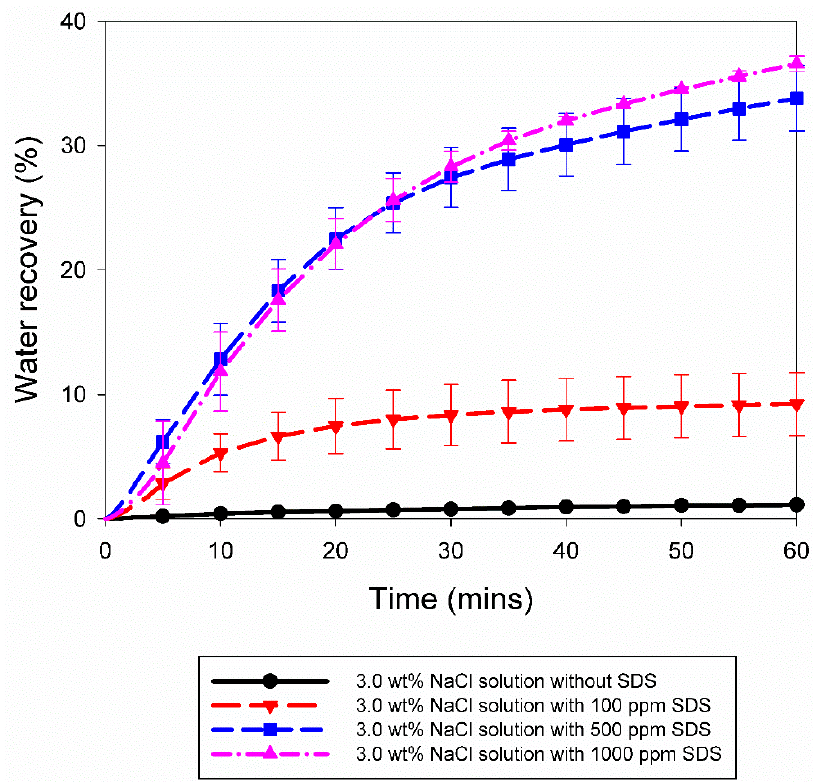
Figure 7. Effect of SDS concentration on water recovery in 3.0 wt% NaCl solution with the 10% propane in argon gas mixture.